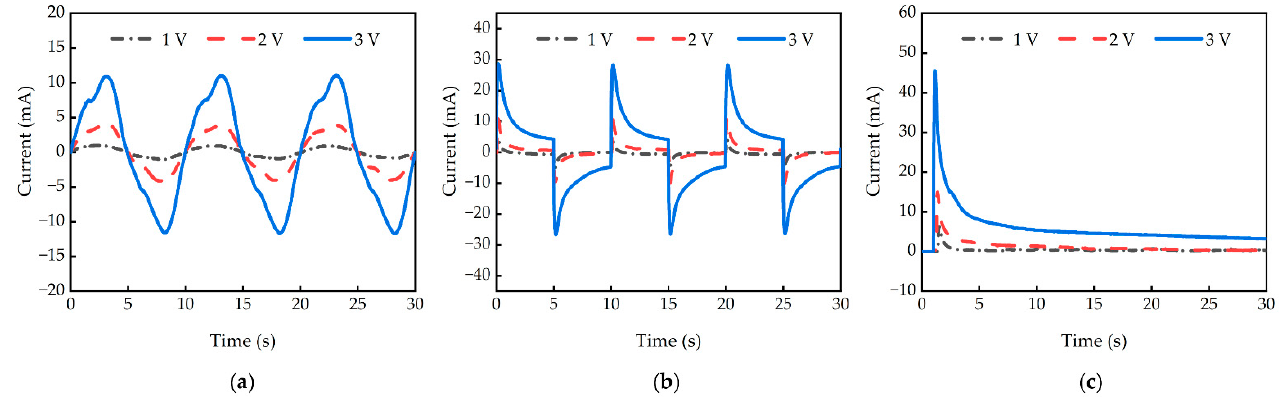
Figure 10. Electric currents of the helical IPMC actuator under different signals with different amplitudes: ( a ) sinusoidal signal; ( b ) square wave signal; ( c ) DC signal.